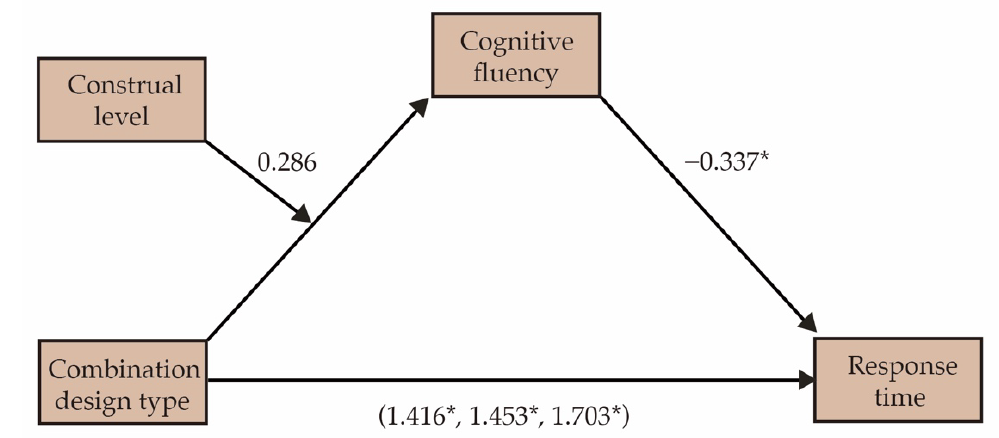
Figure 6. The mediating model of cognitive fluency in response time. Note: * p ≤ 0.05. As shown in Table 6, we also used Ci + Ct in the design type as the virtualized coding benchmark. The results show that the design type (Ci + At, Ai + Ct, Ai + At) has a significant direct impact on the matching rate ( β = − 0.682, Boot-SE = 0.047, p < 0.05; β = − 1.053, Boot-SE = 0.052, p < 0.05; β = − 1.898, Boot-SE = 0.064, p < 0.05), and the 95% confidence intervals of the three tests are in the ranges ( − 0.732, − 0.632), ( − 1.172, − 0.944) and ( − 2.055, − 1.761),